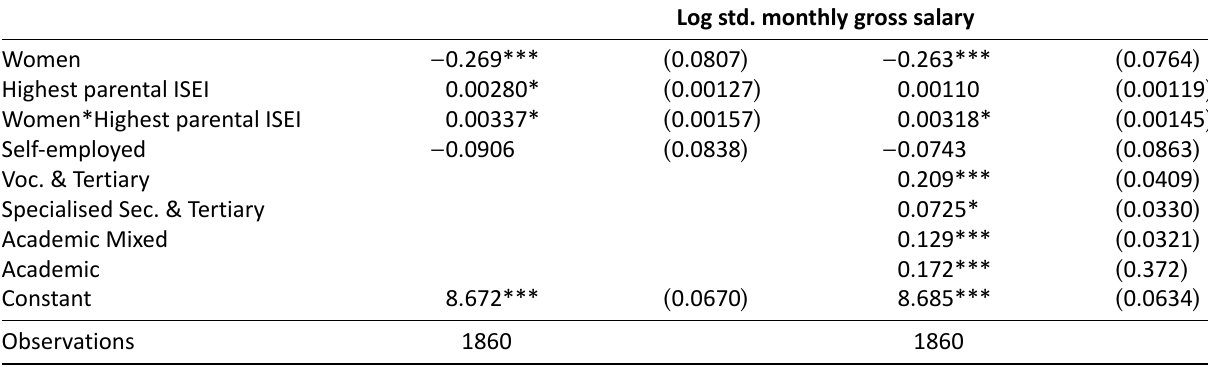
Table 8. Effects on log salary (OLS coefficients).